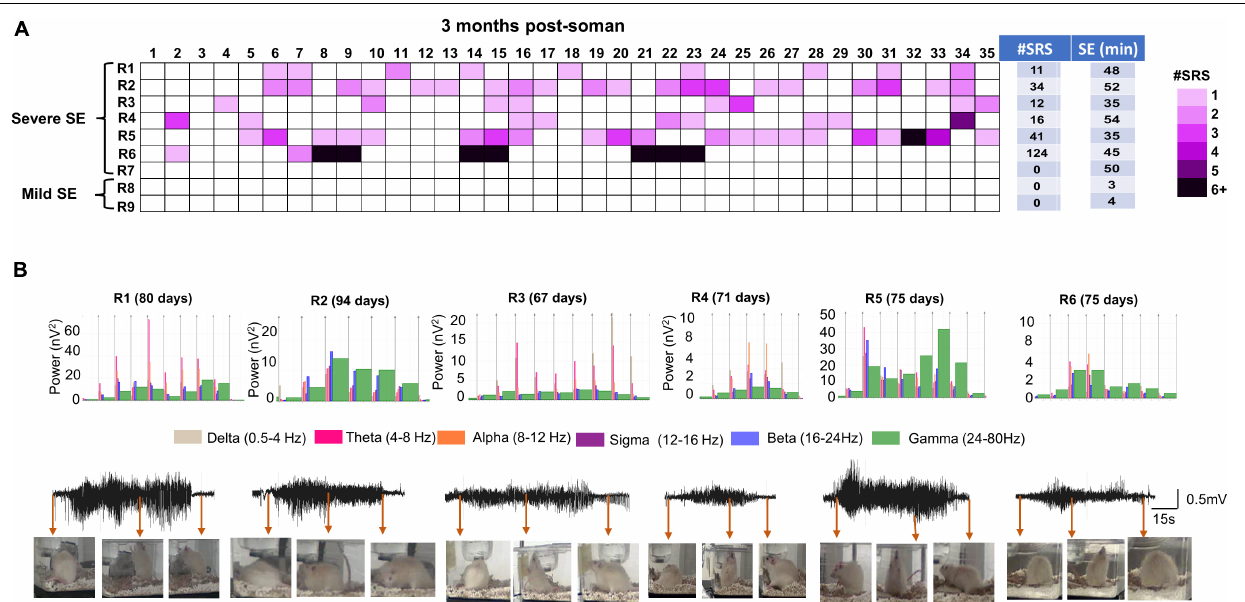
FIGURE 5 | Spontaneous recurrent seizures beginning 2 months post Soman. (A) Heatmap showing the incidence of SRS in male rats during the 35 days of continuous video-EEG observation. Telemetry device was implanted at ∼ 2 months post-SE. Six out of 7 severe SE rats developed SE. Two mild-SE rats did not show any SRS. Initial SE severity and the number of SRS episodes during the observation period is tabulated next to the heatmap. (B) Representative SRS episode and corresponding behaviors captured from integrated video-EEG system, corresponding powerbands are illustrated. R1–R6 represent rat number and the day in parenthesis indicate the SRS occurrence post-soman.